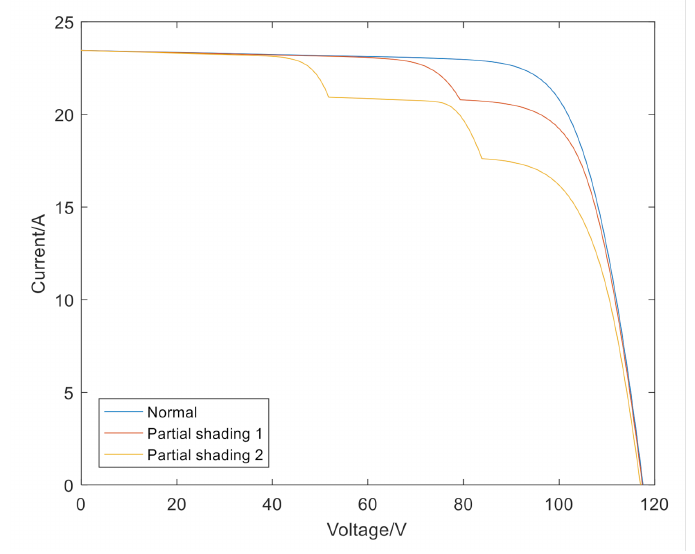
Figure 5. I-V curves of the PV array in case of the partial shading